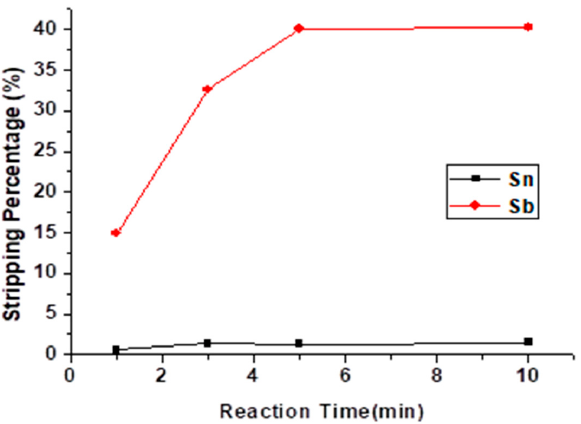
Figure 8. Stripping percentage of Sn and Sb at different reaction times. (HCl) = 9 M, O/A ratio = 1.